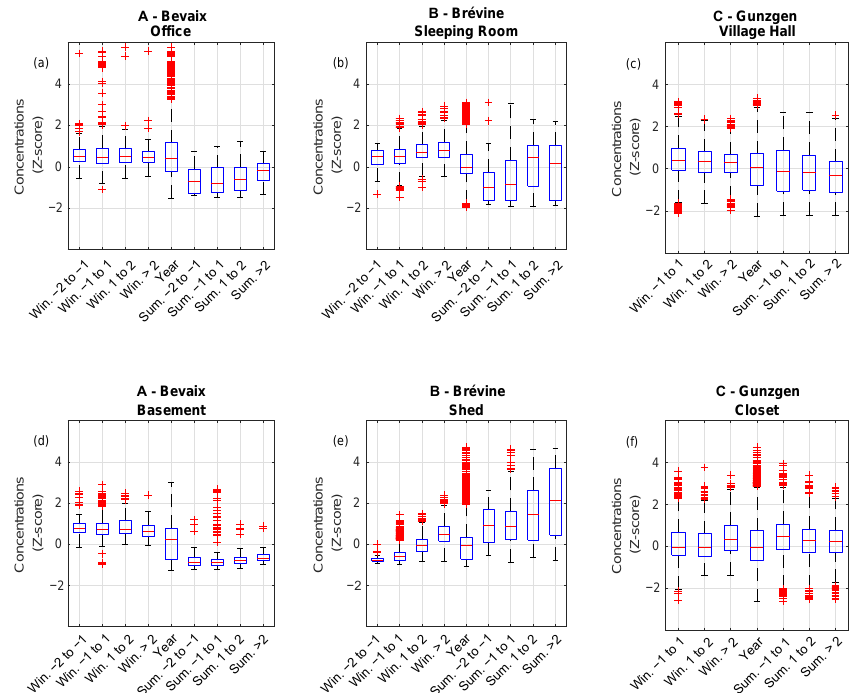
Figure 7. Box-plots synthesizing the impacts of westerly winds on IRC at Bevaix ( a , d ), La Brévine ( b , e ), and Gunzgen ( c , f ). Occupied spaces are shown in ( a – c ) and unoccupied spaces in ( d – f ). Annual standard deviation threshold results are given for both winter and summer. Some of them are missing because they did not